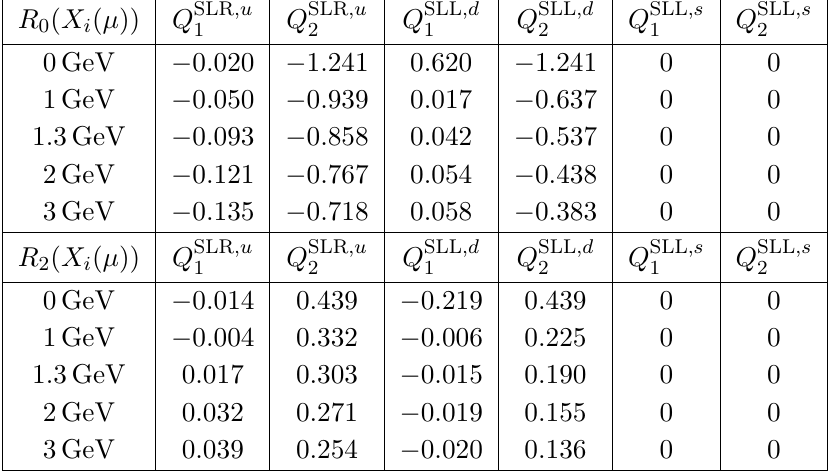
(cid:2) U(1) Q but not by c